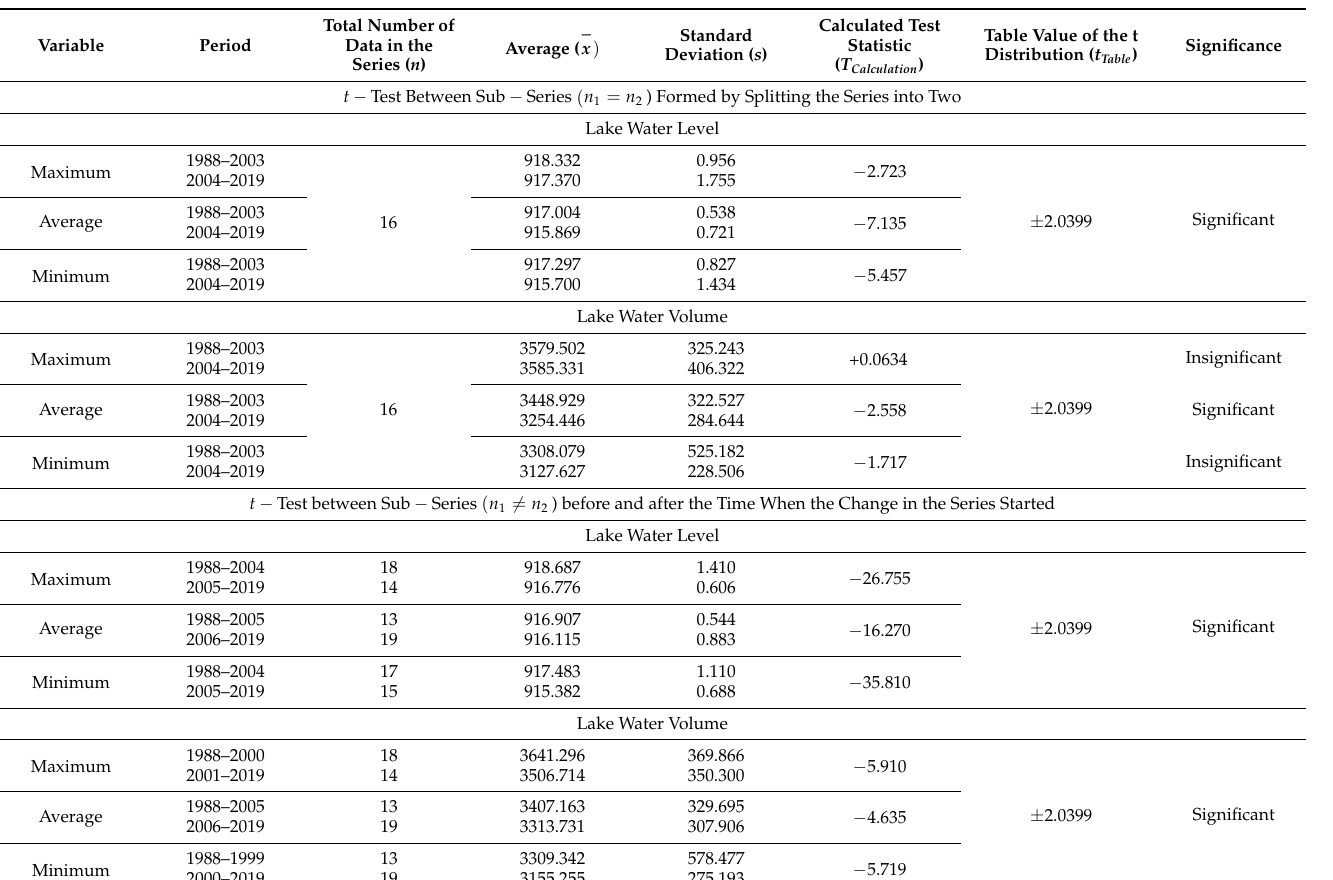
Table 5. The t -test results obtained by dividing the annual lake water level and lake water volume series in